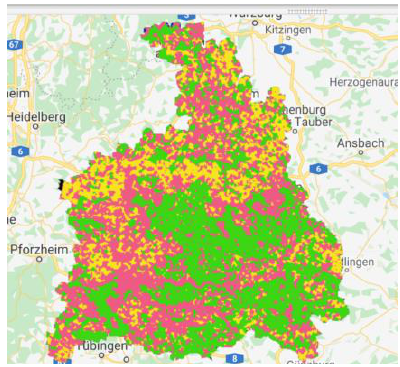
Figure 12: Stuttgart Surface Classification in GEE